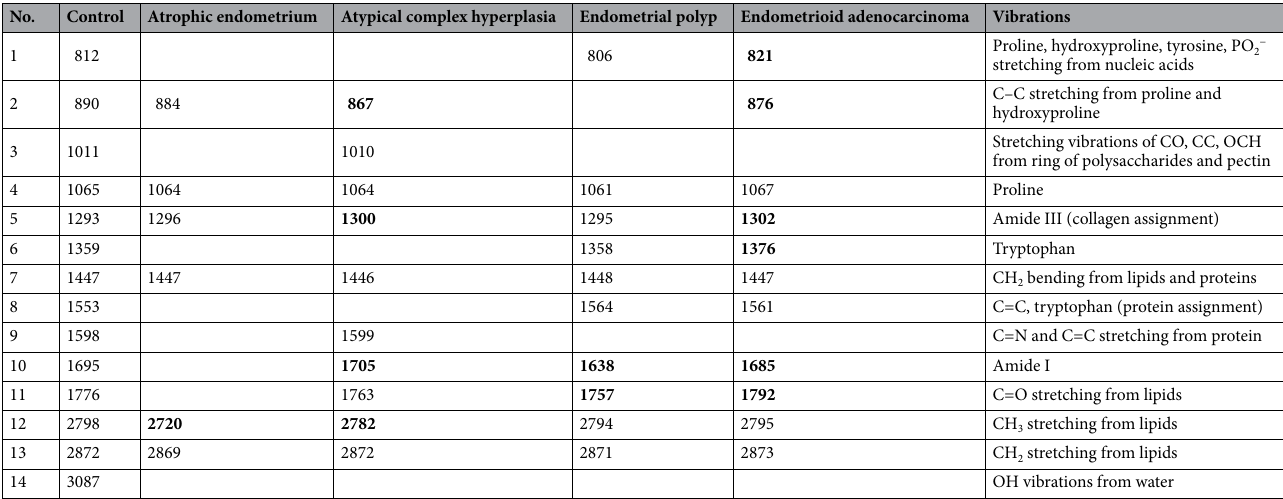
Table 1. Raman shift with corresponding vibrations described in the Raman spectra from Fig. 1 20–24 . Bold means statistically significant